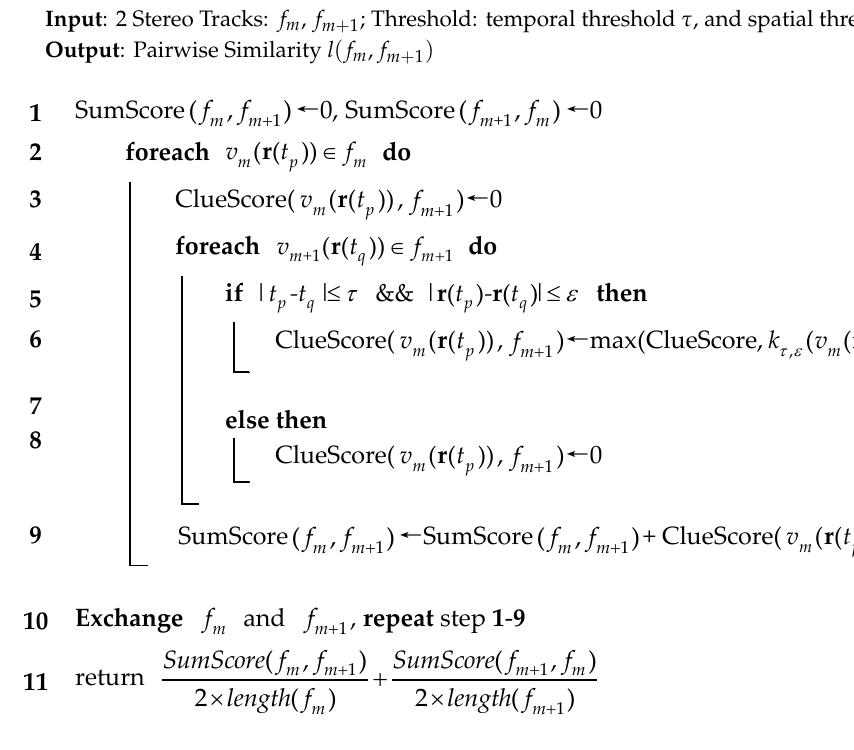
Algorithm 2 : Pairwise Similarity Algorithm